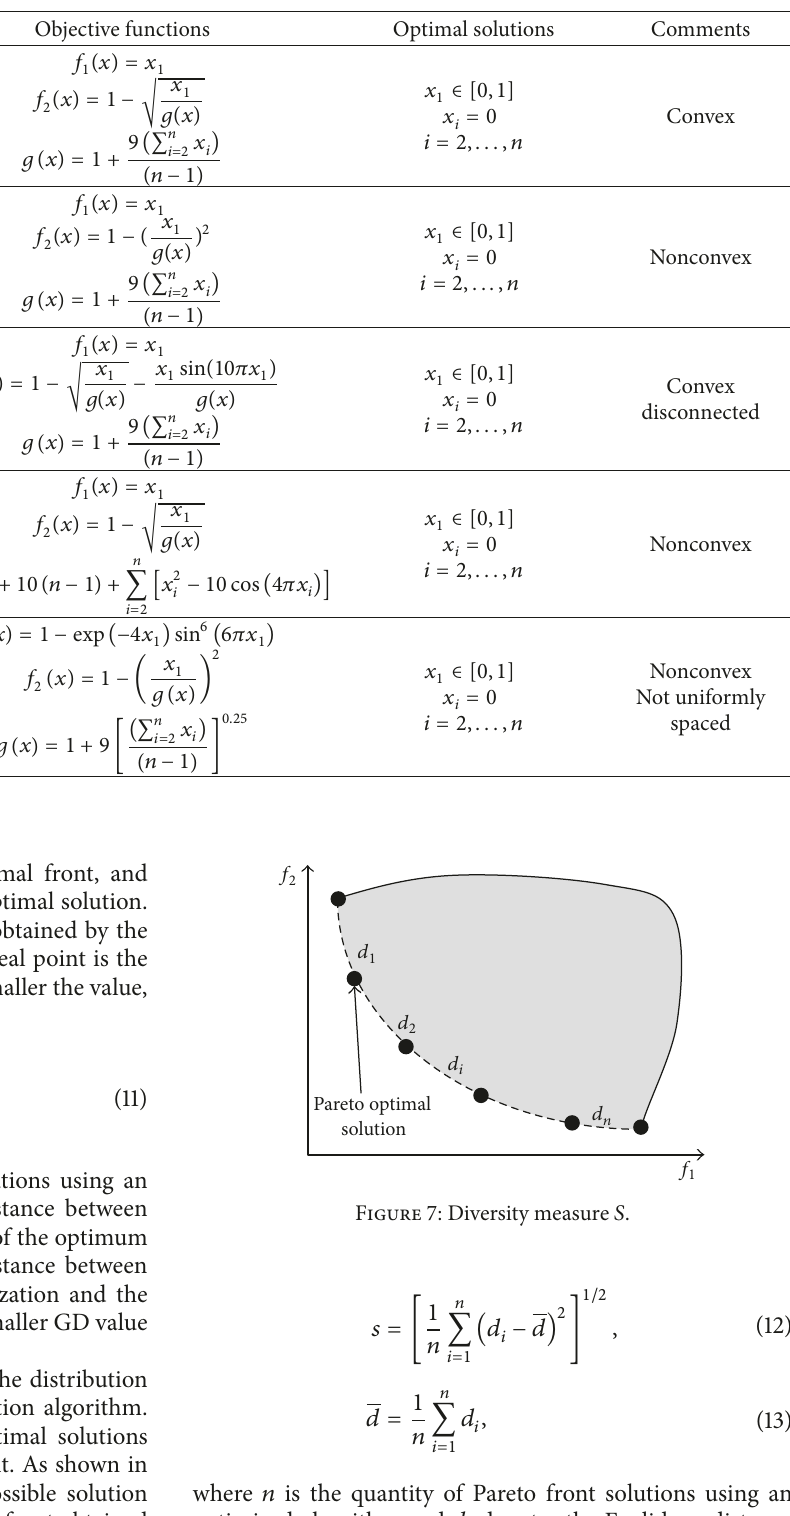
Table 1: Characteristics of test functions.